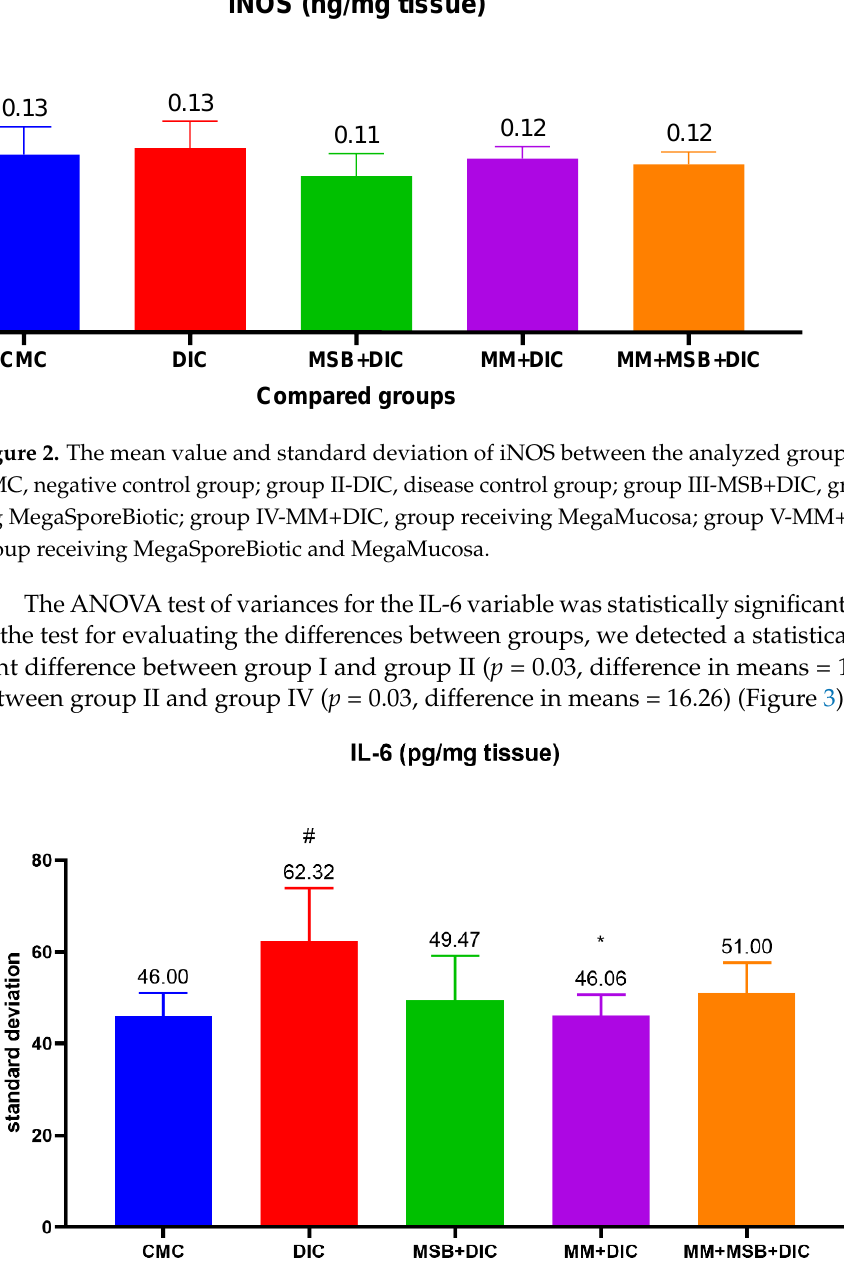
5 of 14 Figure 1. The mean value and standard deviation of PGE2 between the analyzed groups. Group I- CMC, negative control group; group II-DIC, disease control group; group III-MSB+DIC, group re-